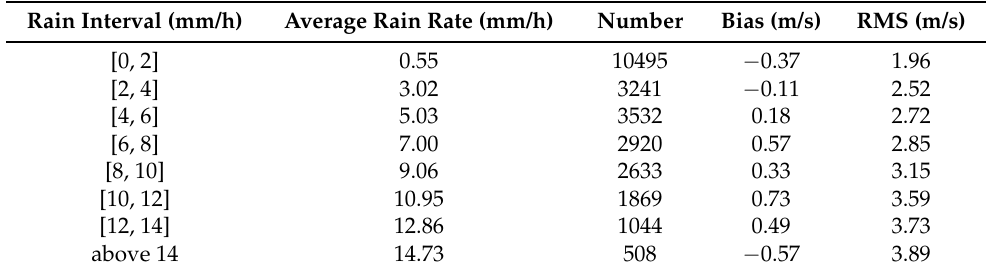
Table 4. The statistics for different rain intervals between H*wind wind speed and the wind speed retrieved with our new